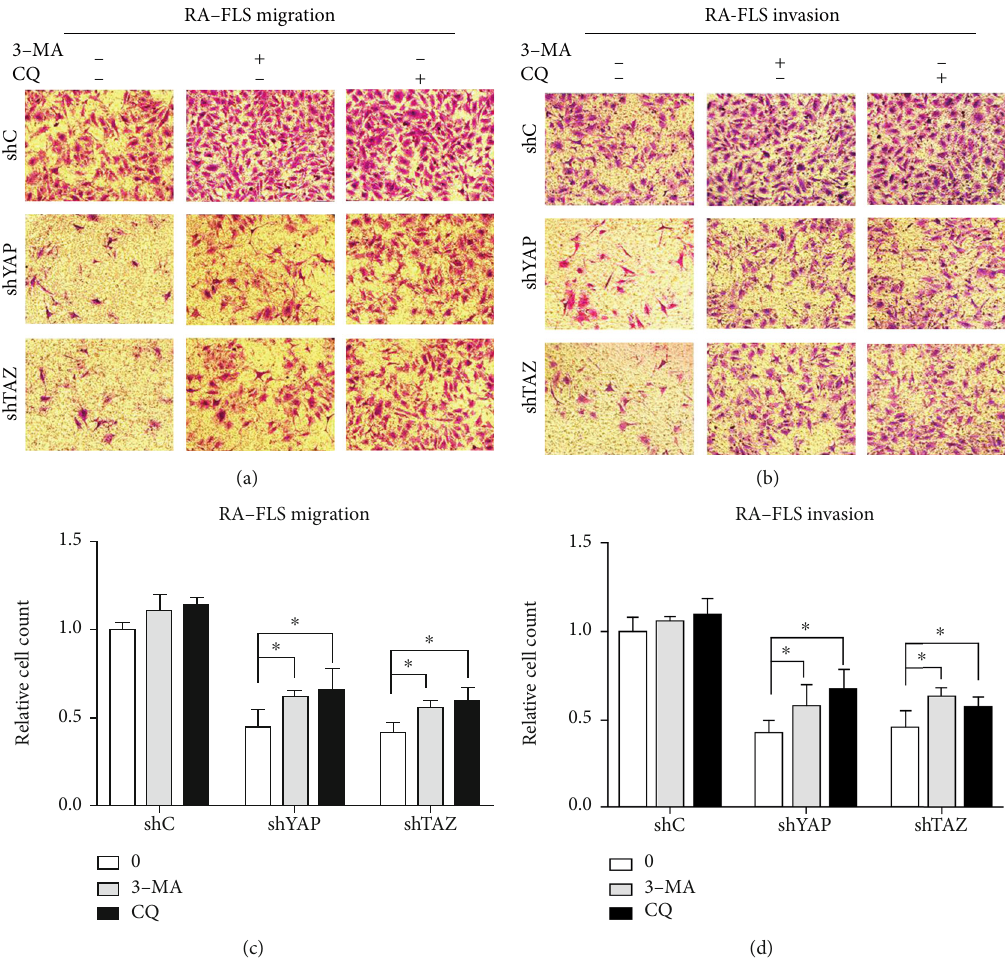
Figure 6: YAP or TAZ knockdown reduced the migratory and invasive ability of RA-FLS through autophagy induction. (a, b) Migration and invasion of stable YAP or TAZ knockdown RA-FLS and their corresponding control cells in the presence or absence of 10mM 3-MA or 30 μ M CQ were determined by Transwell assays. Representative images of three independent experiments are shown. Magni fi cation, × 200. (c, d) Quanti fi cation of relative numbers of migrated and invaded cells in fi ve random fi elds for each replicate was shown. All experiments were performed independently three times, and data were shown as mean ± SD . ∗ P < 0 : 05 relative to shYAP or shTAZ in the absence of 3-MA and CQ by Student ’ s t